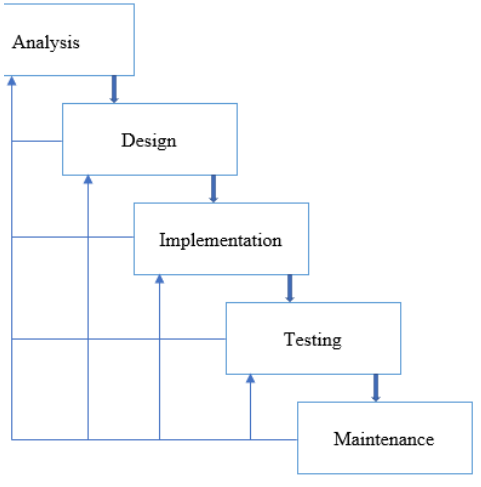
Figure 1. Waterfall model [11].